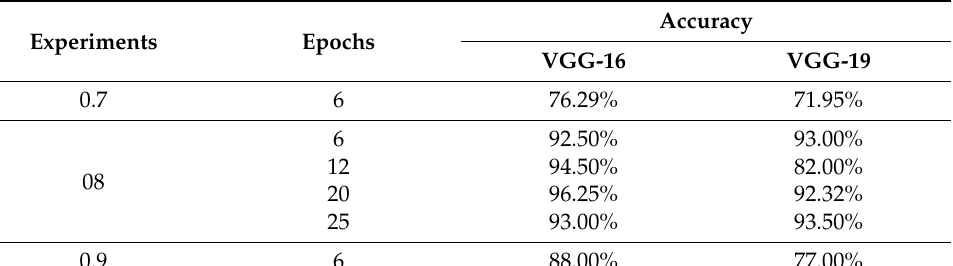
Table 6. Cross-validation and simulation results for VGG-16 and VGG-19 classifiers.